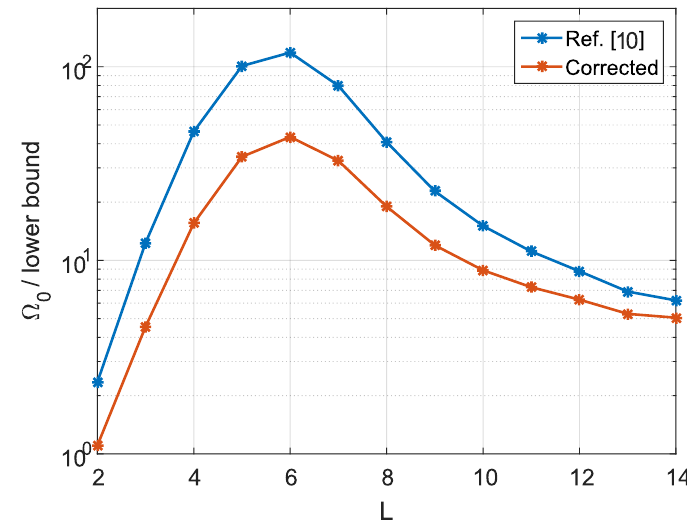
Figure 12: Ratio between the exact number of compatible metacube structures and the lower bounds, using the original lower bound described in Ref. [ 10 ] (blue) and the tighter lower bound of Eq. (7)